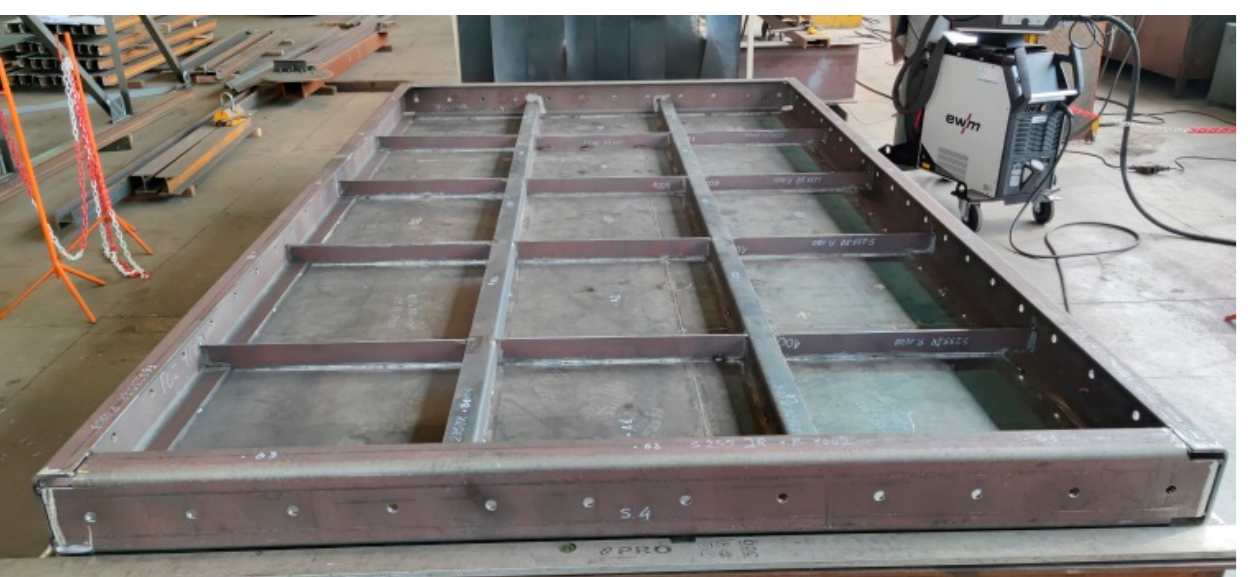
Table 1. Chemical composition of steel S235JRC+N (from metallurgical certificate) in wt.%. Fe C balance The furnace wall panel is a large welded structure made of sheet metal, flat bars, and a channel (Figure 1). The flat panel wall is made of 5 mm thick sheet metal, the outer frame